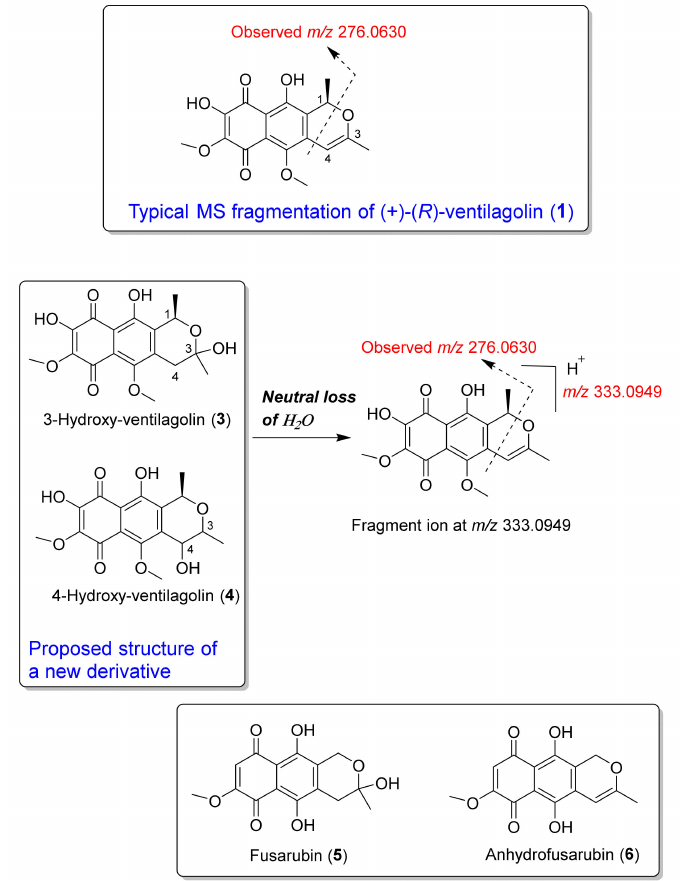
Figure 2. Typical MS fragmentation of ( + )-( R )-ventilagolin ( 1 ); possible structure and MS fragmentations of a new derivative, 3-hydroxy-ventilagolin ( 3 ) or 4-hydroxy-ventilagolin ( 4 ); and structures of fusarubin ( 5 ) and anhydrofusarubin ( 6